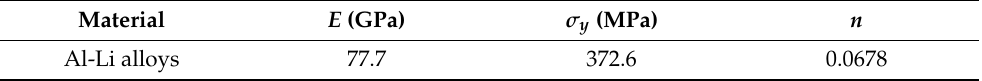
Table 1. Uniaxial mechanical properties obtained from the tensile experiment.